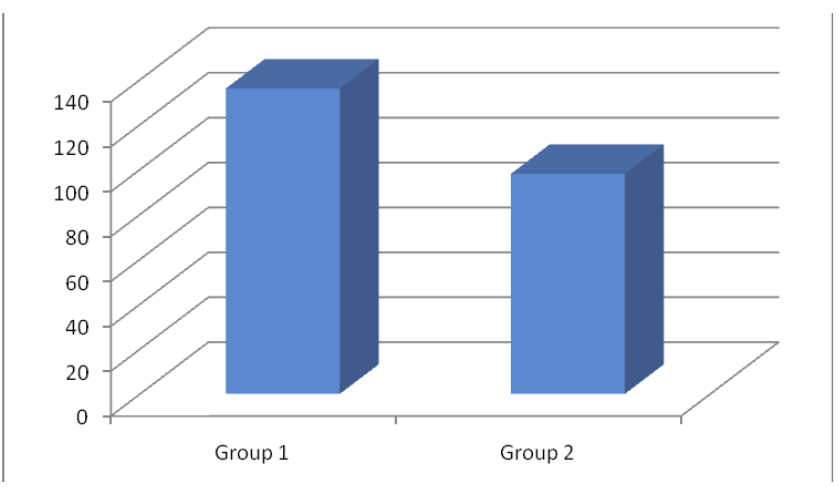
Fig.1 The „adaptability” mean indicators in the LUTA listeners group (Ad_gr1) and the elderly people group who do not study